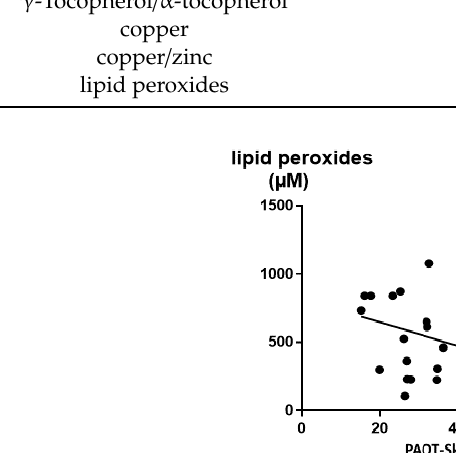
γ -Tocopherol / α -tocopherol